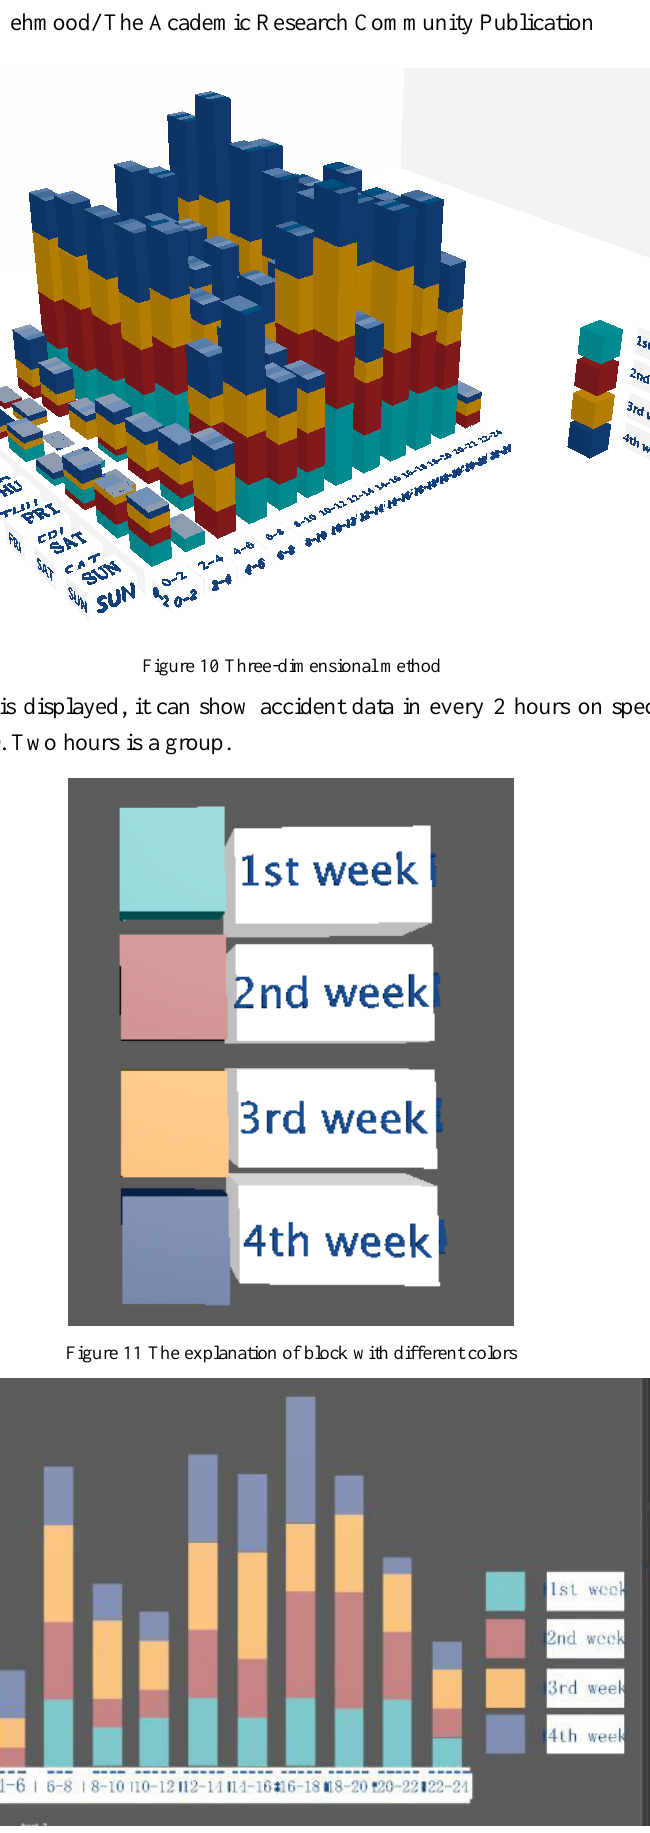
Figure 12 Monday (four